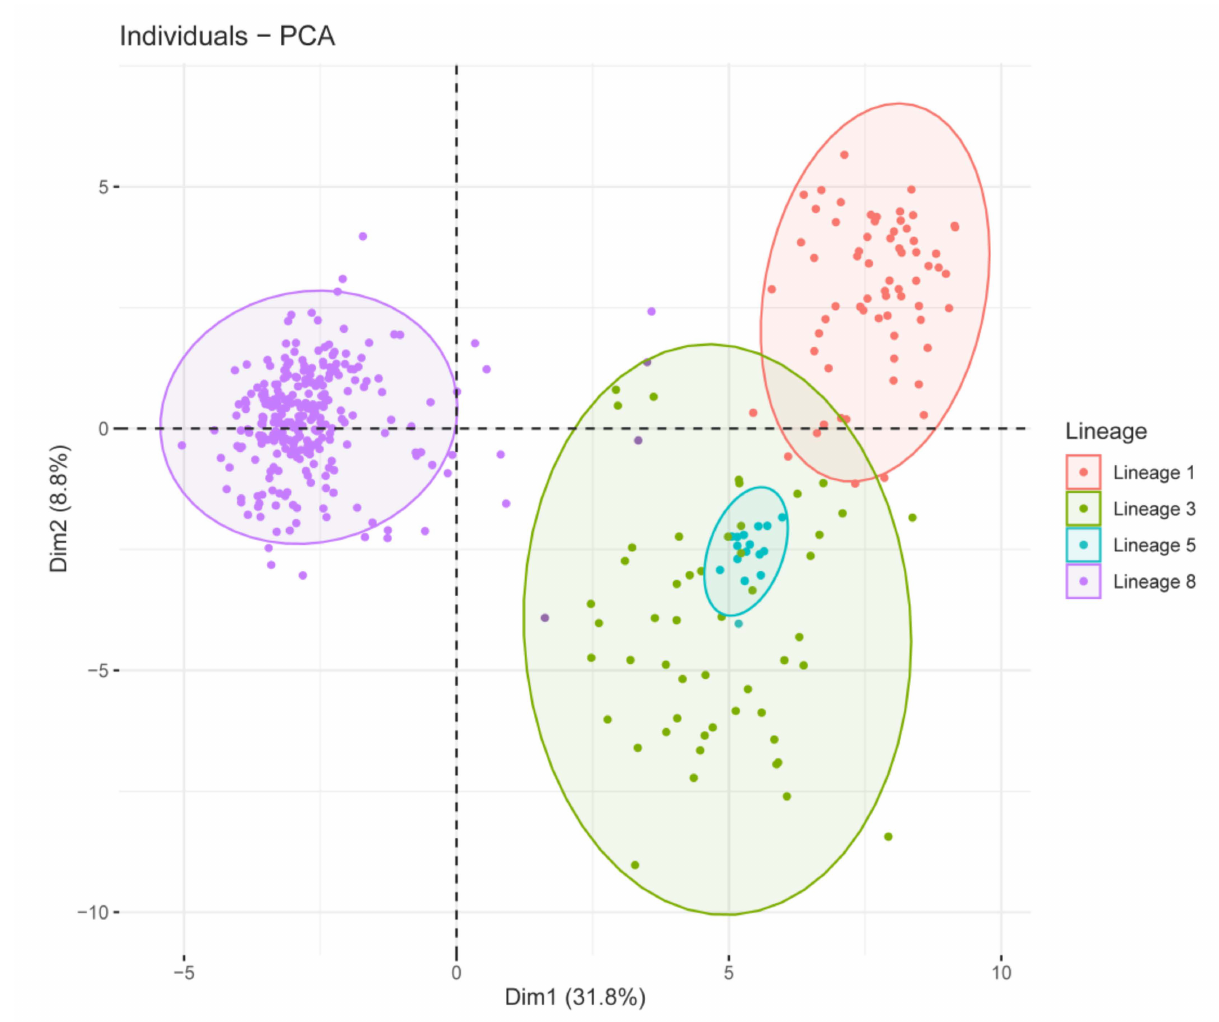
Figure 3. PCA-plot based on ORF5 genes’ RSCU value from different lineages of Chinese PRRSV strains. Codon pair bias ( CPB ) scores of Chinese PRRSV strains were also calculated in this study (Figure 4a). The mean value of lineage 8 ( − 0.045 ± 0.009) is slightly significantly higher than that of lineage 1 ( − 0.049 ± 0.016) and lineage 5 ( − 0.048 ± 0.006) ( p = 0.038 and p = 0.03, respectively), while the mean value of lineage 3 ( − 0.046 ± 0.015) is between